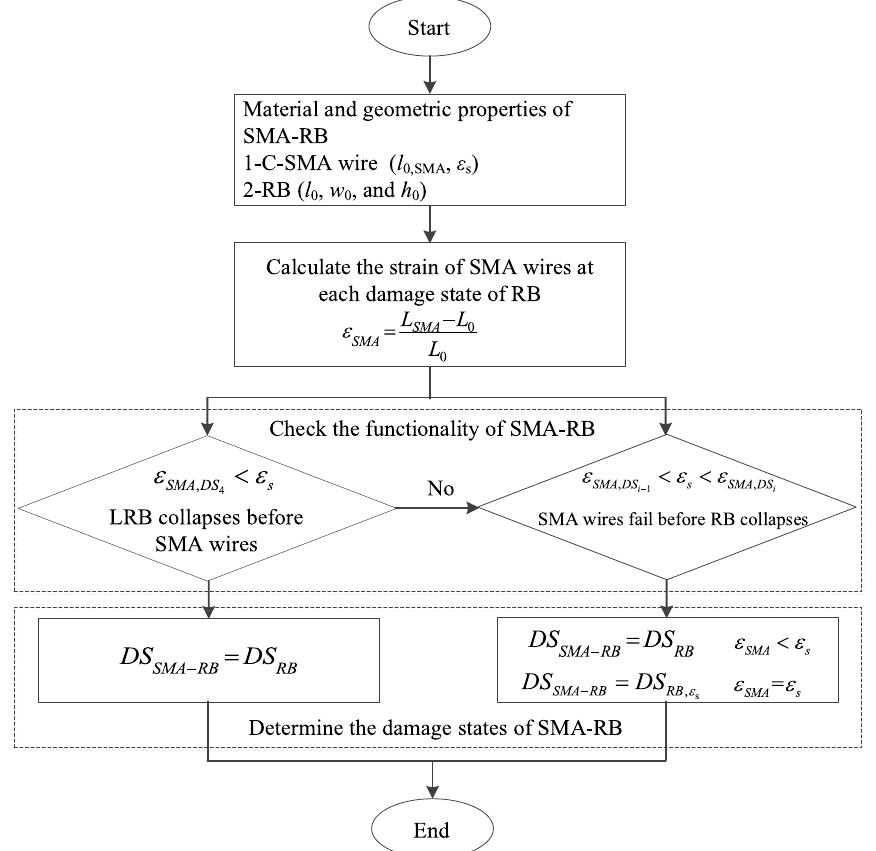
Fig. 8 Flowchart for determining the damage states of